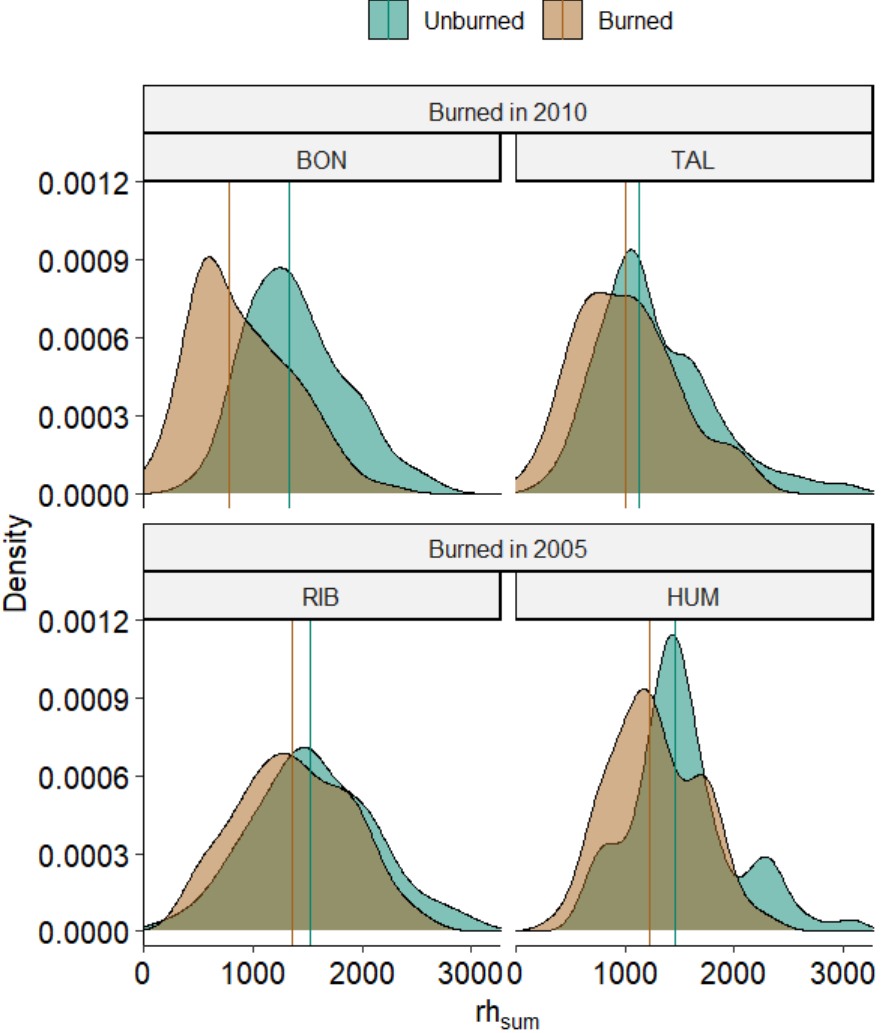
Figure 9. Density distributions for RH sum values, an indicator of fire severity, across fires between burned and unburned samples for four sites. Vertical lines represent median values.